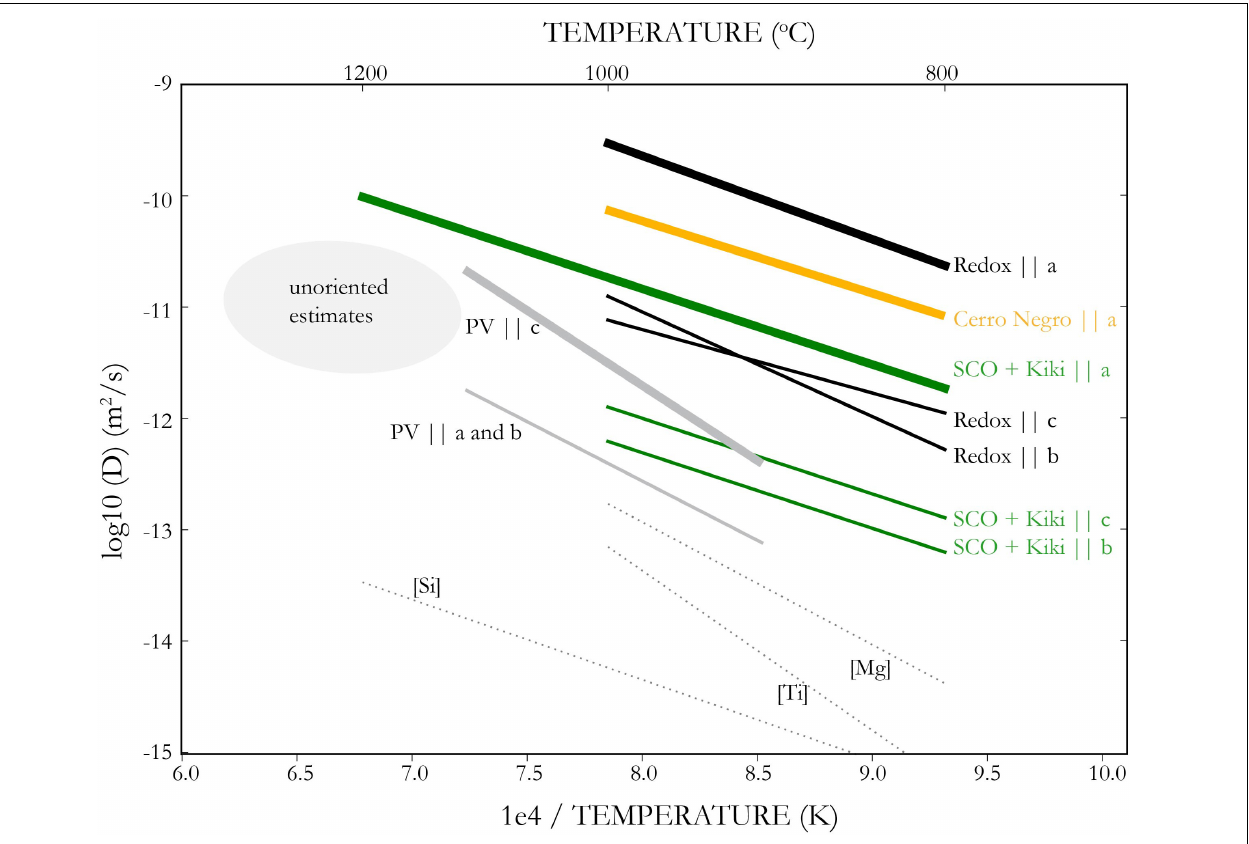
FIGURE 3 | Arrhenius relations for H + diffusion in olivine. Bold lines show rate for fastest crystallographic direction. Black lines proton-polaron (redox) rate, gray lines show proton-vacancy rate during hydration of San Carlos olivine (Kohlstedt and Mackwell, 1998). Peak-specific measurements from dehydration of synthetic forsterite in dotted lines, Padrón-Navarta et al. (2014). Green lines show measurements on San Carlos and Kilauea Iki olivine (Ferriss et al., 2018), yellow lines show rate for low forsterite ( ∼ Fo80) from Cerro Negro (Barth et al., 2019). Estimates for bulk H + diffusivity in unoriented MI-bearing olivines shown by gray ellipse (Portnyagin et al., 2008; Chen et al., 2011; Gaetani et al., 2012; Mironov et al., 2015). This figure illustrates both the strong anisotropy of H + diffusion in olivine and the strong compositional dependence. For the quantitative consideration of MI dehydration in natural, oriented olivines, the relevant Arrhenius relations are for SCO+Kiki (for Fo85-90 olivine) and Cerro Negro (for Fo75-85 olivine) parallel to a .